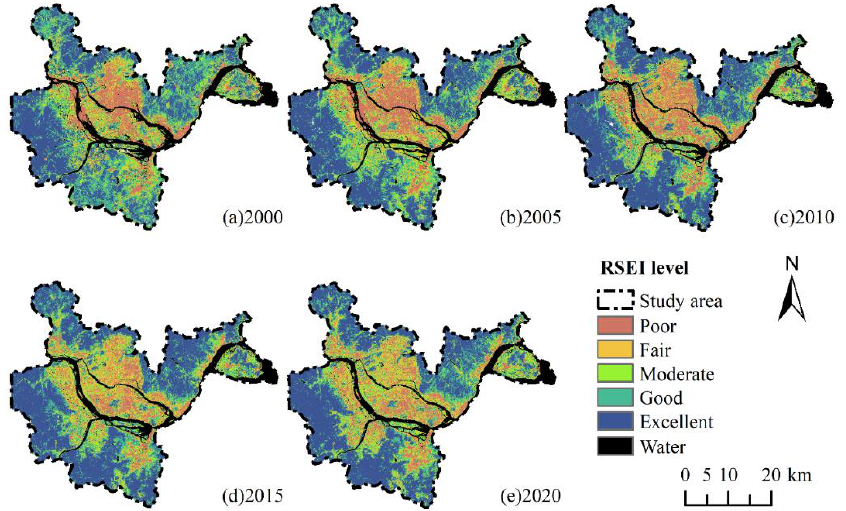
Figure 2. Spatial distribution of RSEI in Fuzhou from 2000 to 2020: ( a )RSEI in 2000; ( b ) RSEI in 2005; ( c ) RSEI in 2010; ( d ) RSEI in 2015; ( e ) RSEI in 2020.